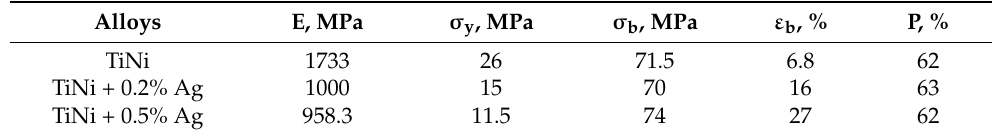
Figure 10. The fracture surface of the alloy sample for TiNi + 0.2% Ag ( a ); TiNi + 0.5% Ag ( b ); σ-ε dependence for the alloys of the TiNiAg system ( c ). Table 6. Mechanical properties of porous TiNiAg alloys.